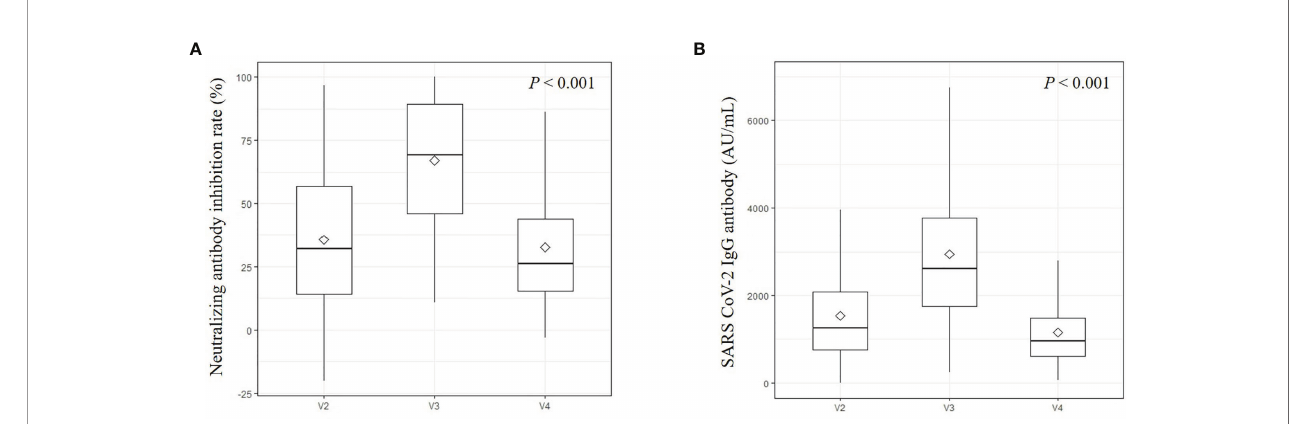
FIGURE 2 | Neutralizing antibody (A) and IgG antibodies against the spike receptor-binding domain of SARS-CoV-2 (B) . This is an antibody titer analyzed at visit 2 (4 weeks after 1 st vaccination), visit 3 (3 months after 2 nd vaccination), and visit 4 (6 months after 2 nd vaccination). Diamond marks were represented as mean